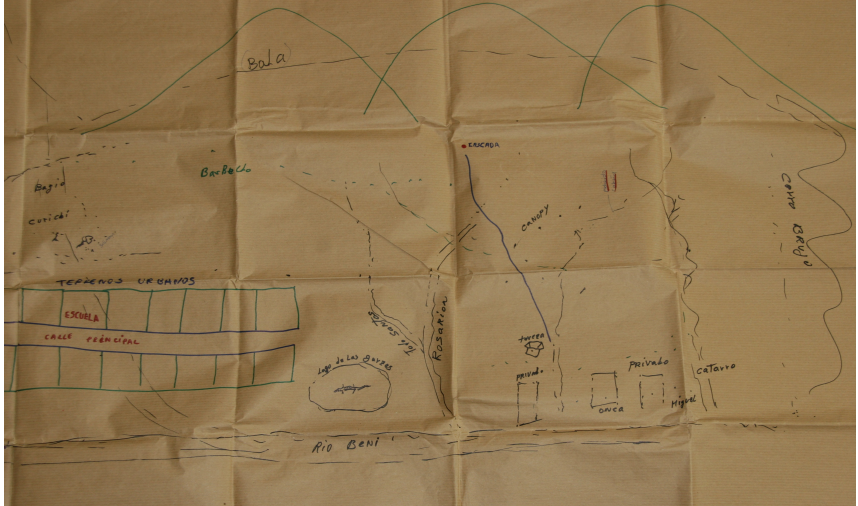
Figure 4. Example of a sketch map with a blend of aerial view and sideways